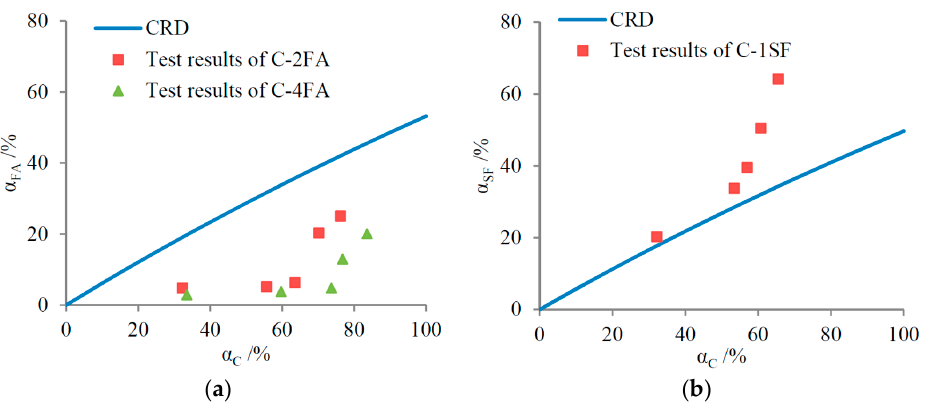
Figure 7. Predictions of effects of SCM replacements in binary systems: ( a ) FA; and ( b ) SF.